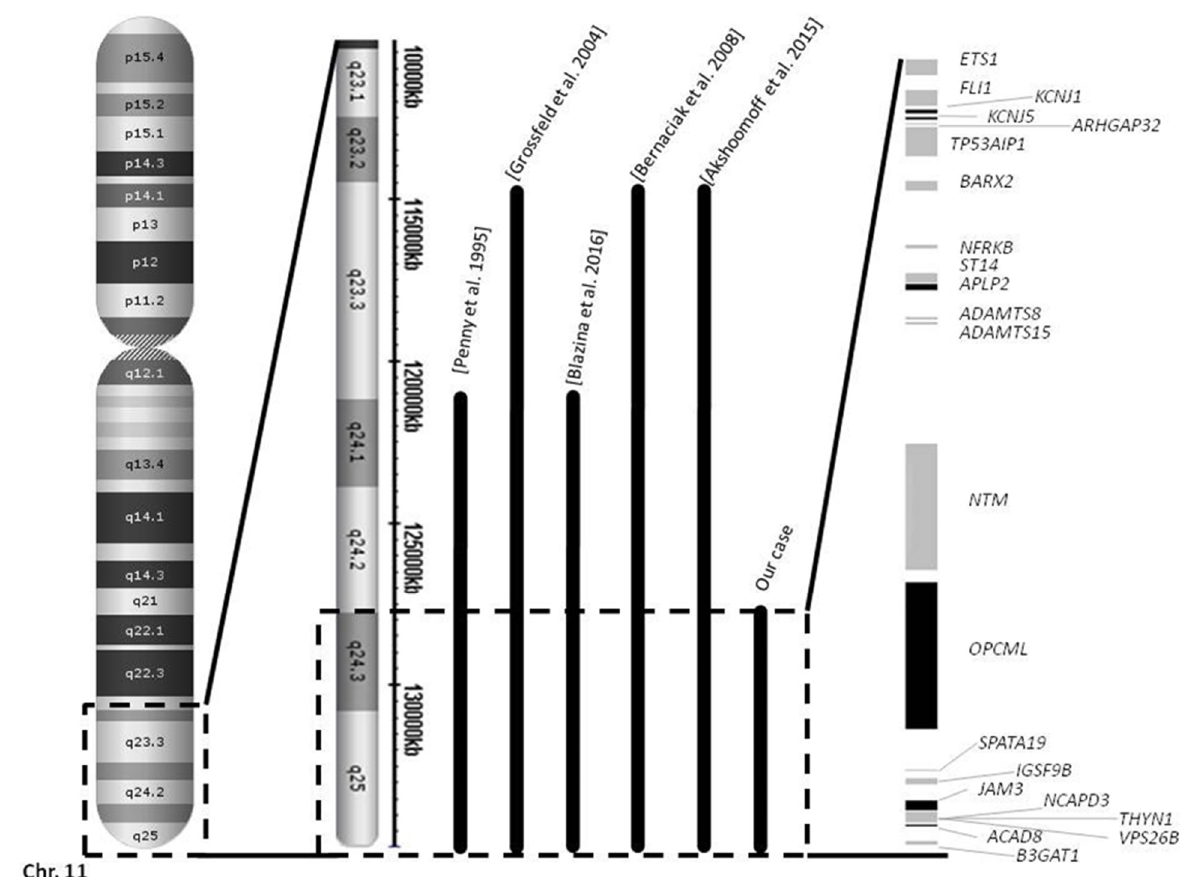
Figure 2. Deletion of 11q24.3-q25 carried by a partial JBS patient. Chromosome 11, showing the critical region of JBS, is shown on the left. Comparison between the published deletions carried by JBS patients with immunodeficiency [5,8–11] (Bernaciak et al., 2008 [8]; Blazina et al., 2016 [9], Grossfels et al., 2004 [10], Penny et al., 1995 [11]) and the deletion carried by our patient. On the right, the deleted genes in our patient are detailed. Haploinsufficiency of the FLI-1 gene has been proposed as the genetic alteration responsible for the immune system defects in JBS, for both our patient and other patients he has been compared